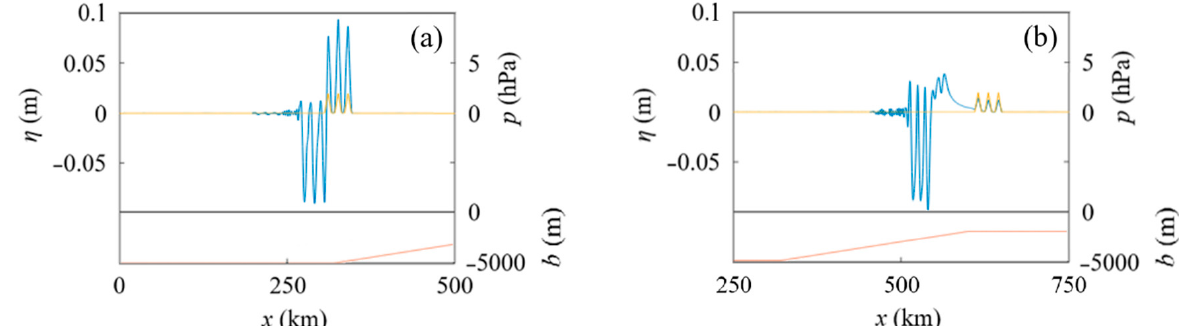
Figure 12. Water surface profiles in Case I, where x 1 = 55 km and δ = 5 km in Figure 1; h on = 2000 m, x slope = 320 km, x on = 600 km, and the slope gradient β = 1.07 × 10 − 2 in Figure 2b. The blue, orange, and red lines indicate the water surface displacement η , atmospheric pressure p , and seabed position b , respectively. ( a ) t = 1190 s. ( b ) t = 2380 s.